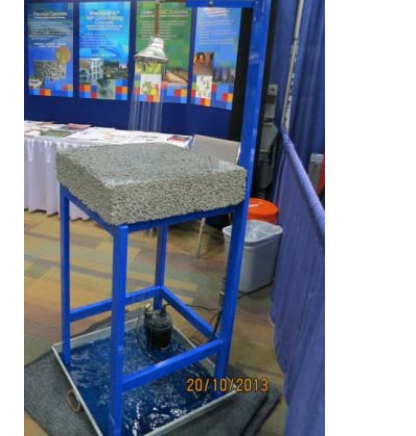
Figure 3. Water infiltration in PCPC.